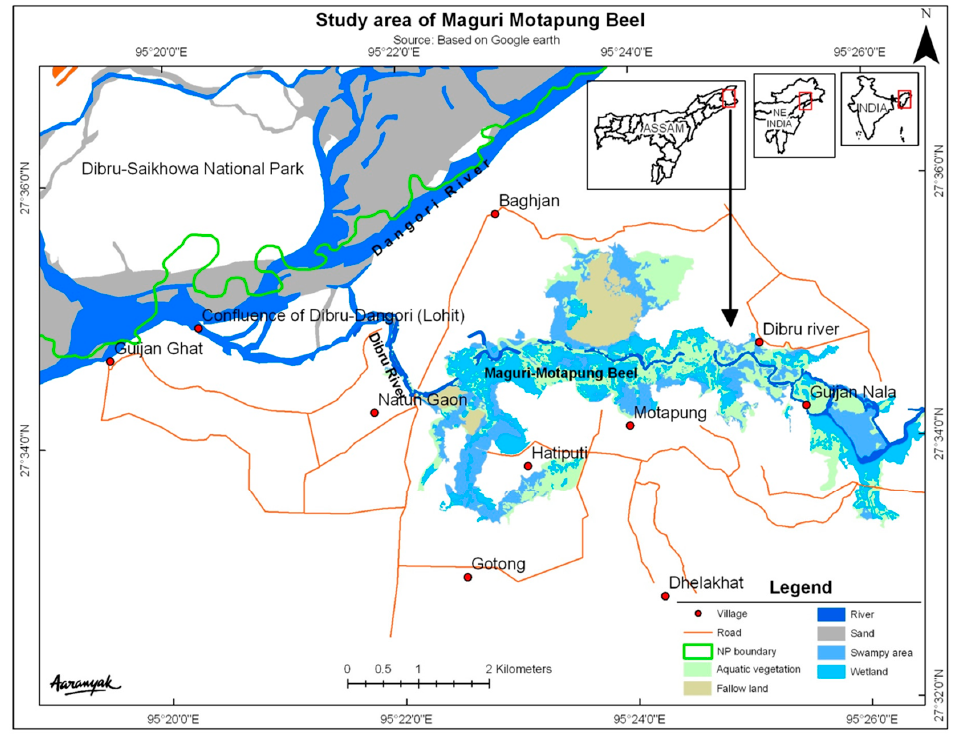
Figure 1. Study area of Maguri-Motapung Beel wetland.